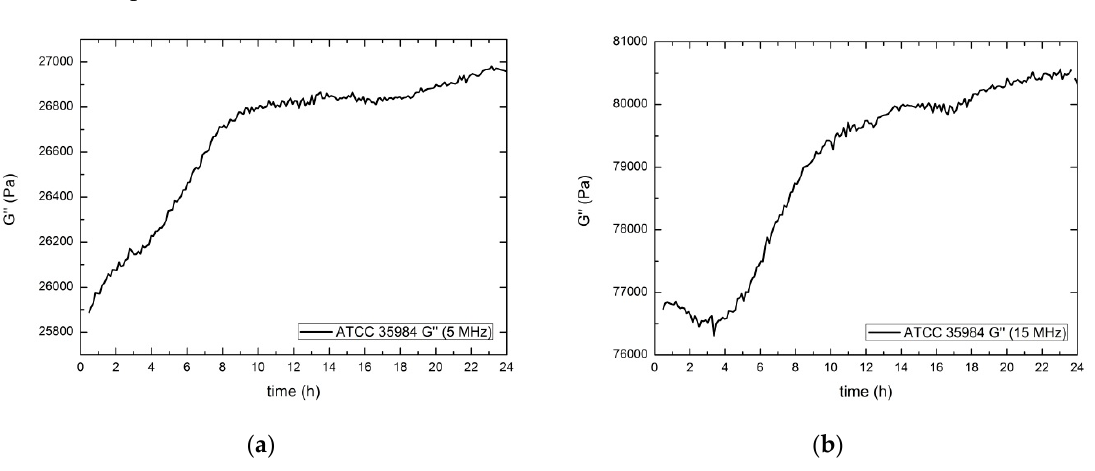
Figure 8. Evolution of the imaginary shear modulus for 5 MHz ( a ) and 15 MHz ( b ). Results obtained for S. epidermidis ATCC 35984 producer strain.